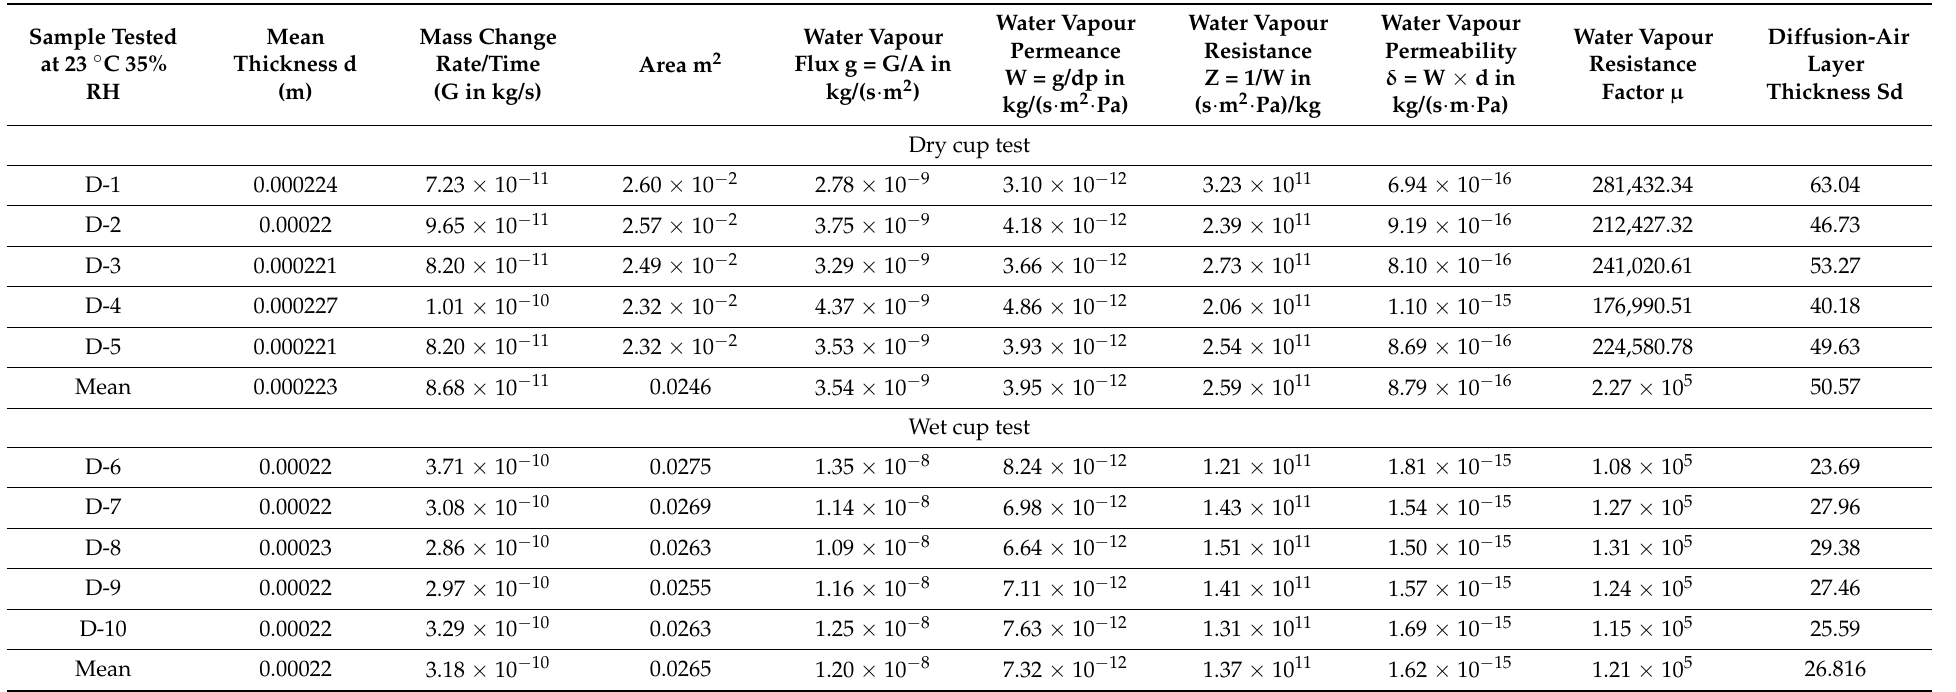
Table A6. Water vapour resistivity properties for sample D at 23 ◦ C 35%